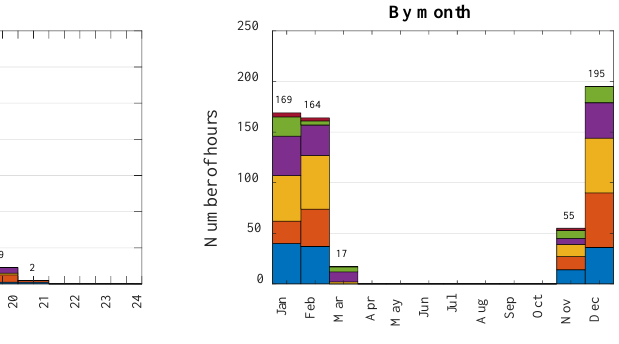
Figure 4. Highest load hours during 2018–2021.